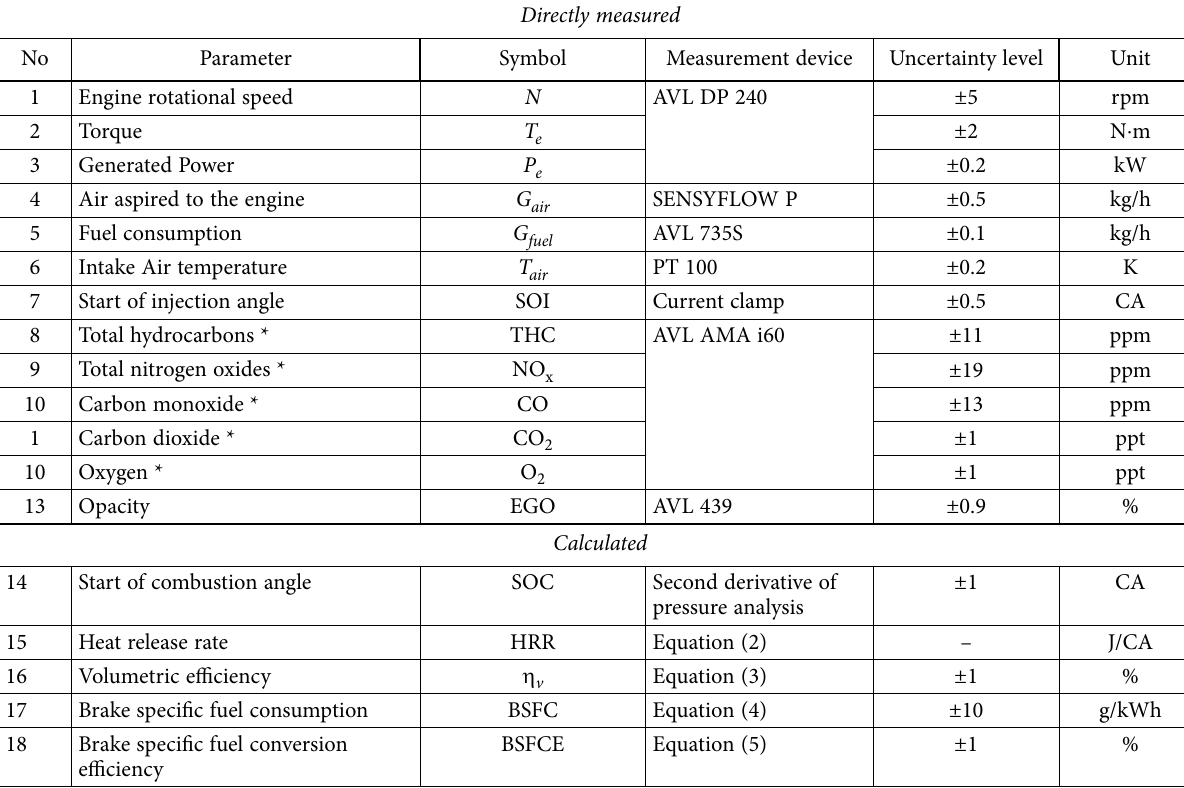
Table 4. List of parameters recorded directly and derived indirectly from calculation, along with achieved maximum uncertainty Directly